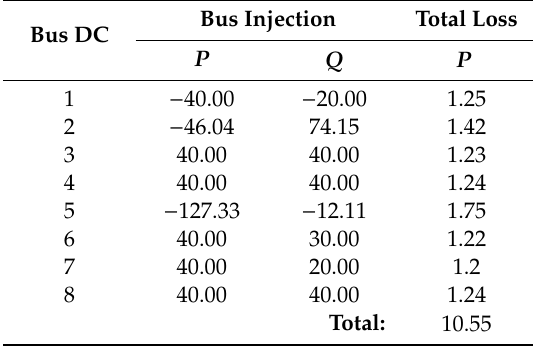
Table A48. Results of the mixed AC / DC PF calculations in Case 7-5. DC bus data.